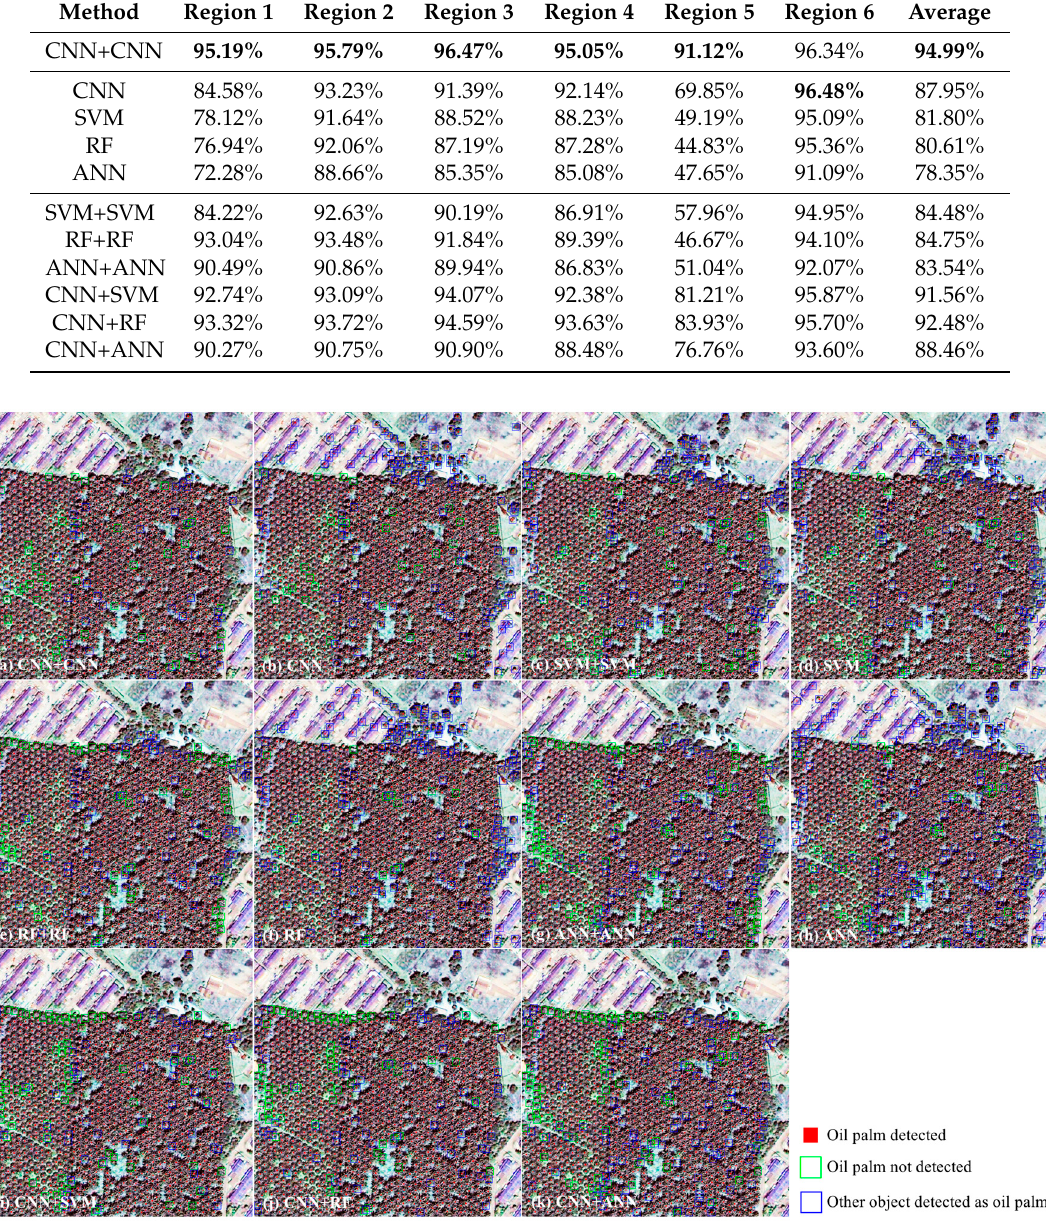
Figure 8. The image detection results of all methods ( a – k ) in Region 2.